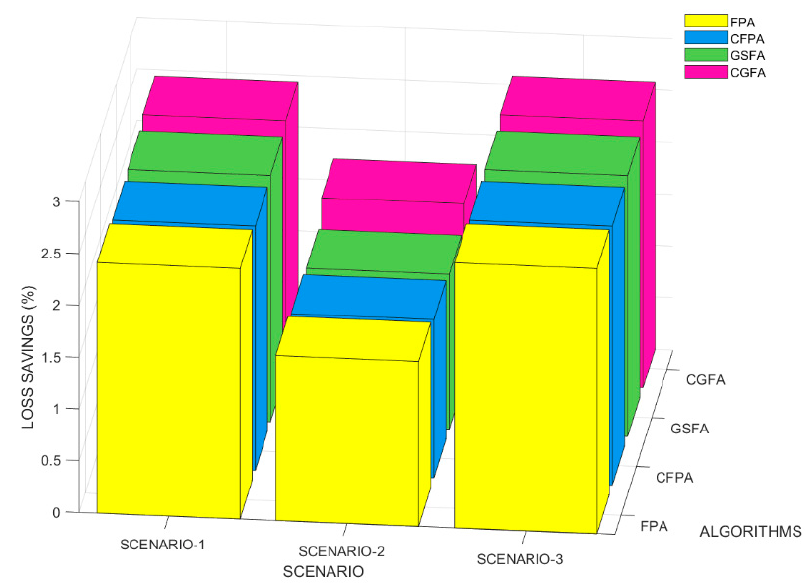
Figure 14. Percentage loss savings of different algorithms in Indian 52-bus system.